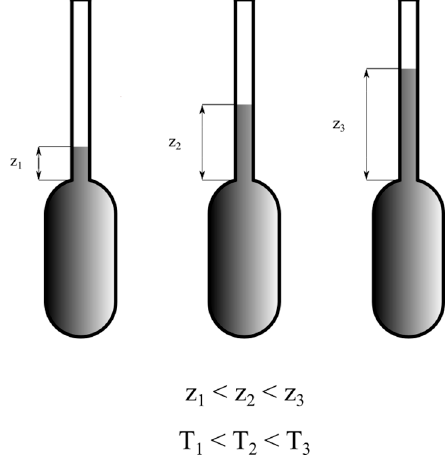
Figure 1. Liquid-in-glass thermometer at three different temperatures.